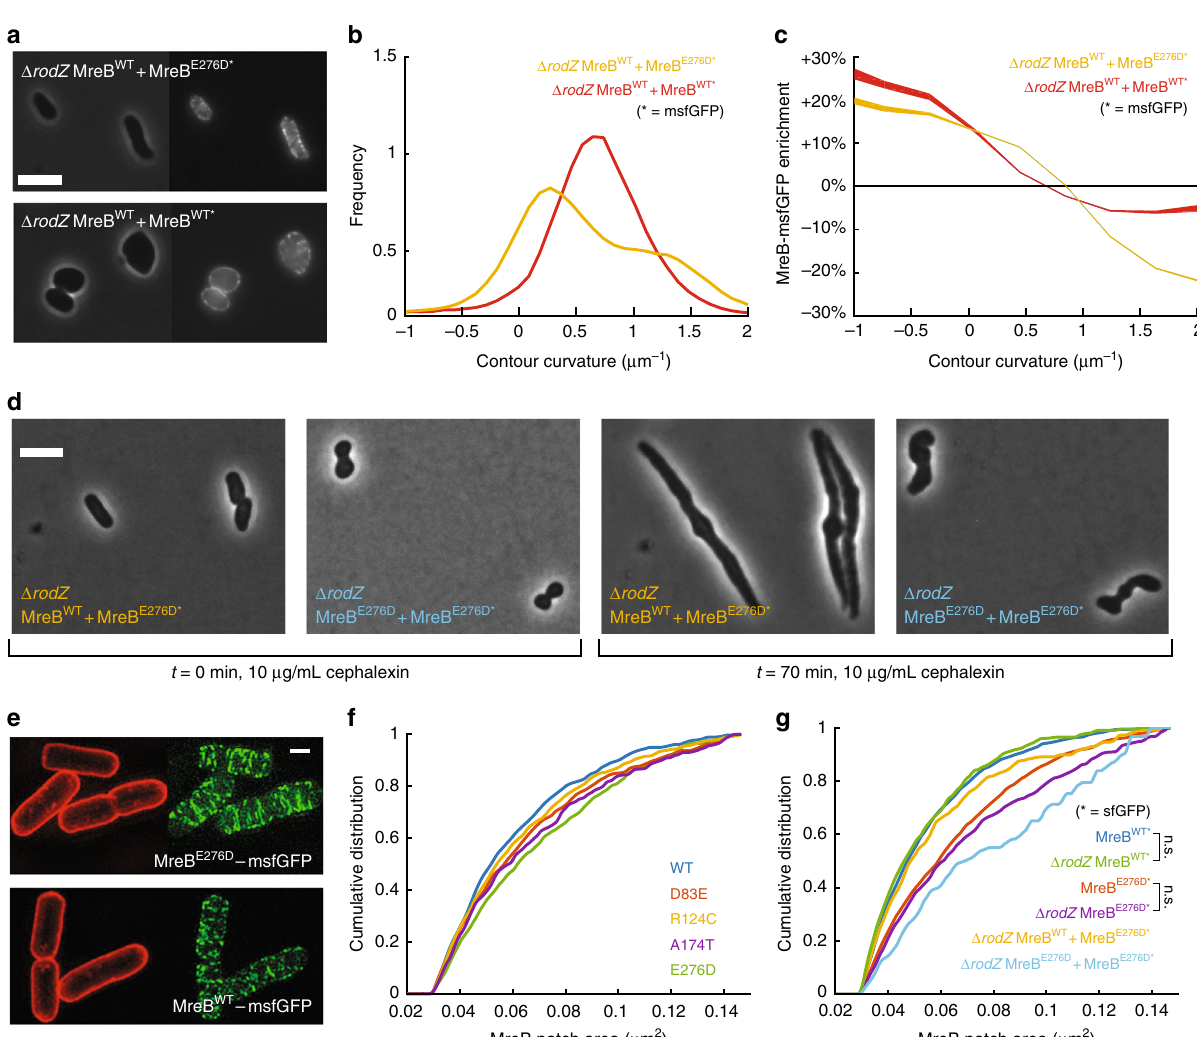
Fig. 5 Concurrent expression of MreB E276D -msfGFP and MreB WT recovers rod shape in Δ rodZ cells. a Rod shape was rescued in Δ rodZ cells with chromosomal expression of MreB WT by introducing a plasmid-borne copy of MreB E276D -msfGFP (top), but not with a plasmid-borne copy of MreB WT - msfGFP (bottom). Scale bar is 5 µ m. b Δ rodZ MreB WT + MreB E276D* cells exhibited a bimodal contour curvature distribution with one peak centered near zero, characteristic of rod-shaped cells, unlike the unimodal distribution of Δ rodZ MreB WT + MreB WT* cells. c Δ rodZ MreB WT + MreB E276D* cells exhibited enhanced depletion of MreB E276D -msfGFP at high-contour curvature as compared with MreB WT -msfGFP in Δ rodZ MreB WT + MreB WT* cells. The variable thickness of the solid line represents the standard error at each time point. d When division was inhibited by cephalexin (10 µ g/mL), most (80%) Δ rodZ MreB WT + MreB E276D* cells maintained a rod-like shape after doubling in length, while only 50% of Δ rodZ MreB E276D + MreB E276D* cells elongated by twofold in 70 min . Snapshots of cells shown before (left) and after (right) 70 min of cephalexin treatment. Scale bar is 5 µ m. e Structured illumination microscopy revealed that the MreB E276D -msfGFP mutant strain had qualitatively longer fi laments than the strain harboring MreB WT -msfGFP. Red fl uorescence represents FM 4-64FX membrane staining. Scale bar is 1 µ m. f The cumulative distributions of MreB-msfGFP fl uorescence patch sizes for Δ rodZ suppressor MreB mutants were intermediate between those of MreB WT and MreB E276D . Each MreB patch was de fi ned as a continuous region larger than the diffraction limit with high-GFP signal located within the cell contour. n > 50 single cells were analyzed for each strain. g Patch sizes for varied widely across strains, as indicated by the cumulative distribution of MreB-msfGFP fl uorescence. Strains containing MreB E276D -msfGFP consistently showed distributions indicative of larger patch sizes ( p < 10 − 18 , t -test). Deletion of RodZ alone did not lead to statistically signi fi cant differences in the distribution of MreB patch sizes. n > 50 single cells were analyzed for each